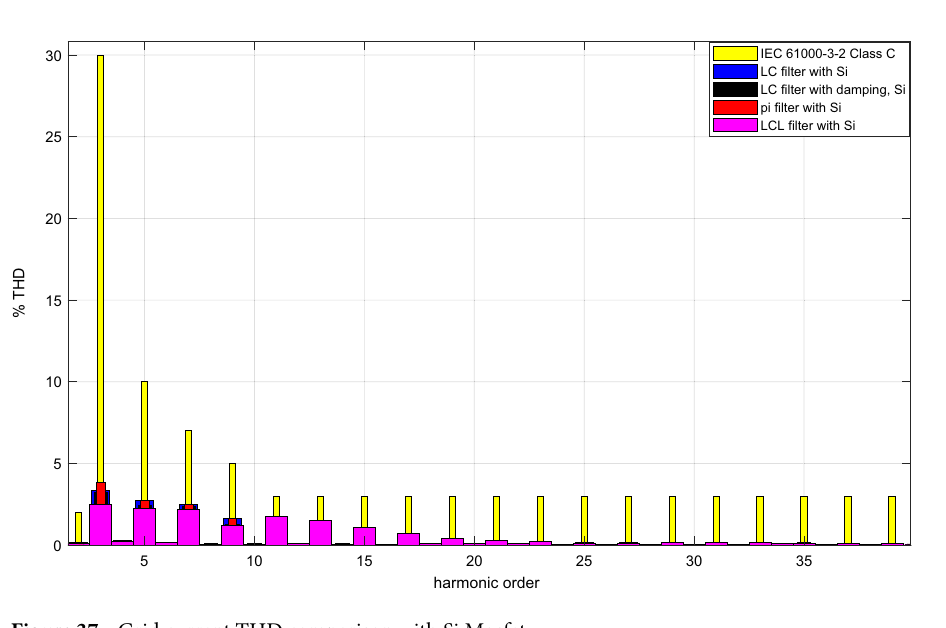
Figure 37. Grid current THD comparison with Si